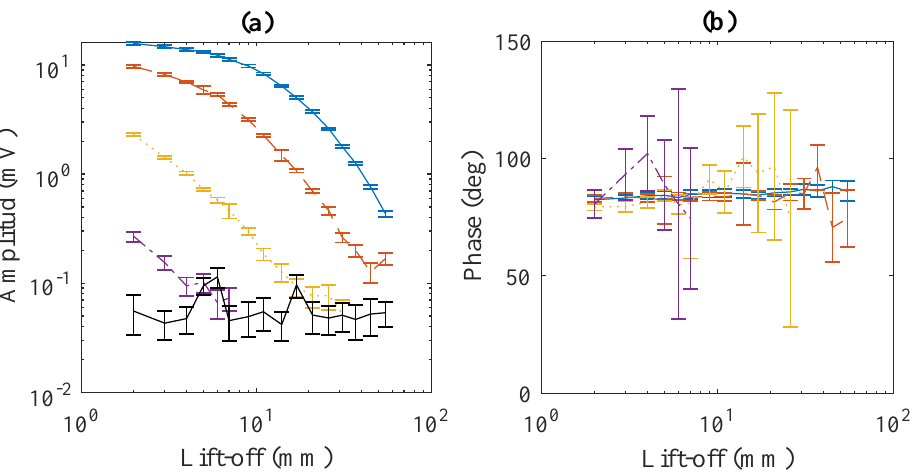
Figure 5. Amplitude ( a ) and phase ( b ) of the rf resonance measured a function of coil lift-off (2mm to 55mm) for a single point over the centre of a square copper plate angled at 30 ◦ , with a side length of 40mm (blue solid line), 20mm (orange dashed line), 8mm (yellow dotted line), and 4mm (purple dash-dotted line). The black line represents the signal measured over a 40mm plate at 0 ◦ . The measurement was performed at an operating frequency 40kHz. Each point is an average of 50 measurements, and the errors bars represent one standard